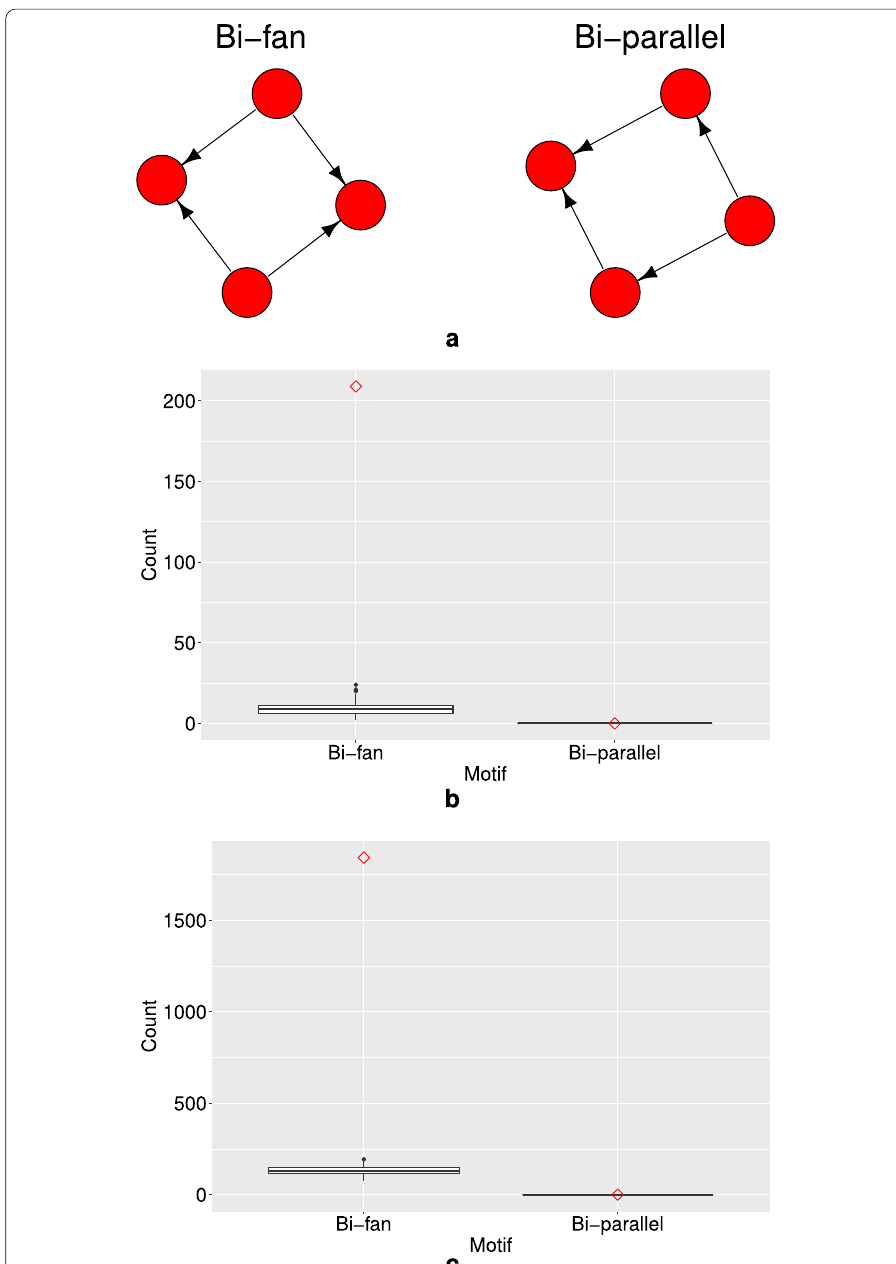
Fig. 7 ( a ) The bi-fan and bi-parallel four-node motifs. Goodness-of-fit plots for these motifs for ( b ) the Alon E. coli regulatory network Model 1 (Table 6), and ( c ) the Alon yeast regulatory network Model 1 (Table 7). The observed network statistics are plotted as a red diamond, with the statistics of 100 simulated networks plotted as black